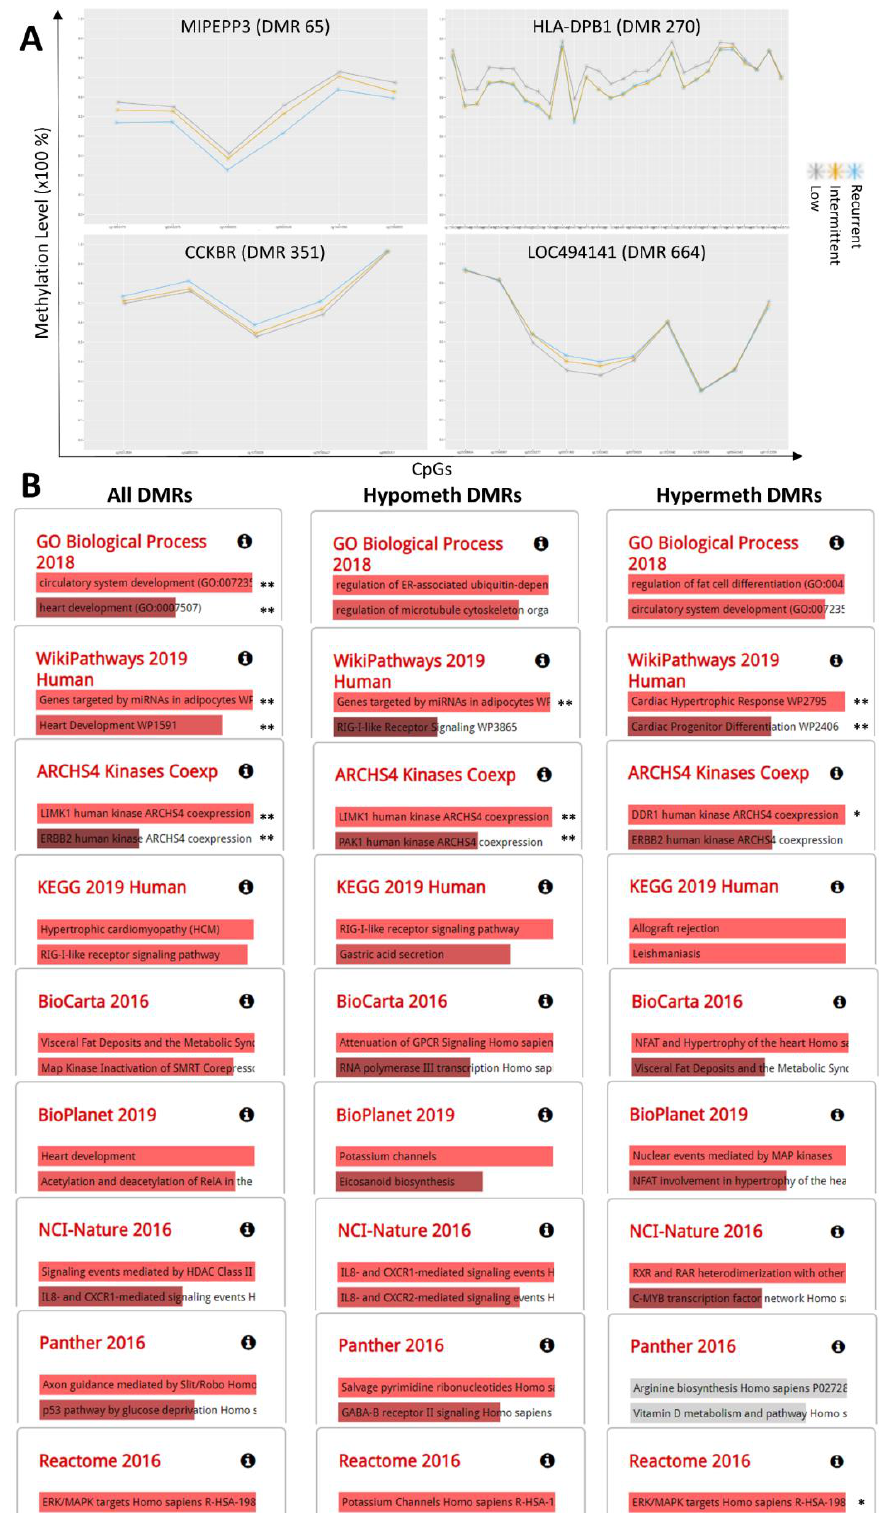
Figure 4. ( A ) Top DMRs obtained from the AF recurrent vs. low AF exposure adjusted model, with their methylation levels on the y -axis and their constituent CpGs on the x -axis. The DMRs in the MIPEPP3 and HLA-DPB1 genes represent the two DMRs with the largest number of